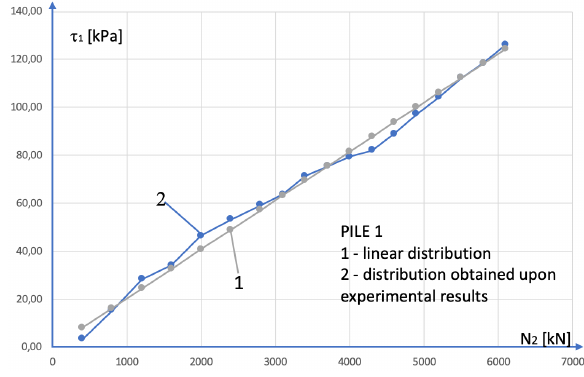
=5,28. 2 Figure 10a: Pile 1 values comparison; linear distribution for B